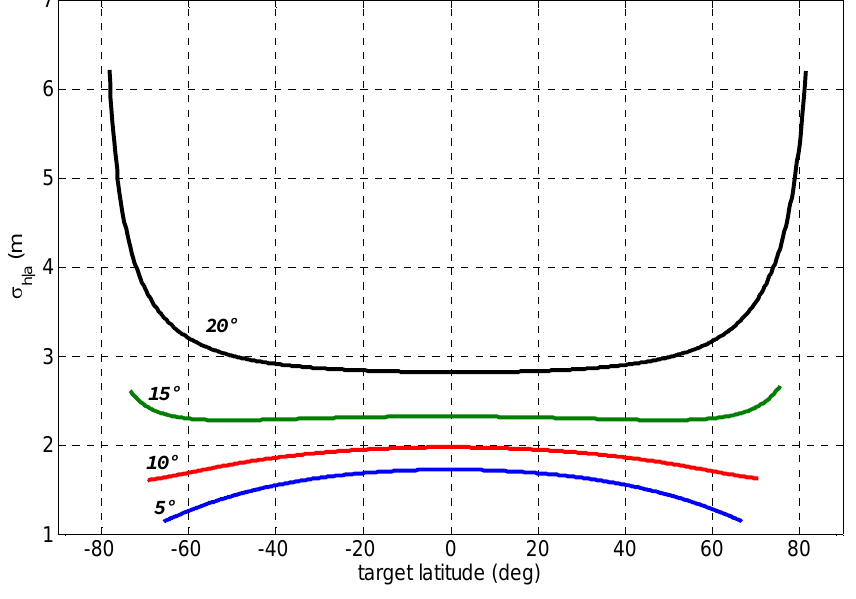
Figure 11. Height uncertainty as a function of target latitude due to vector parallax difference uncertainty in the hybrid method for four bistatic off-nadir angles (1/10 of an image pixel assumed as co-registration uncertainty).